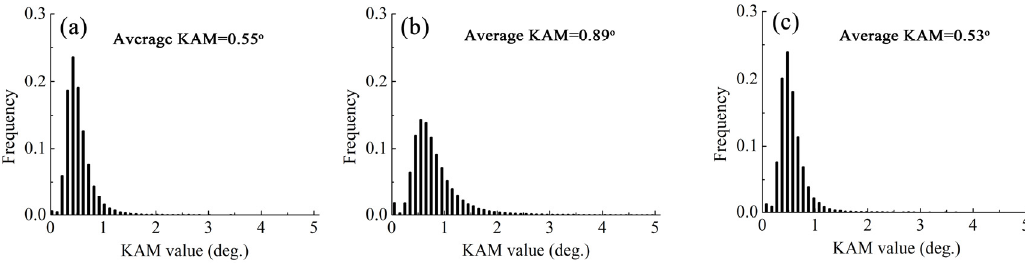
Figure 3. Distribution of KAM value in various samples ( a ) as-rolled (AR) sample; ( b ) WB sample and ( c ) WBA sample.